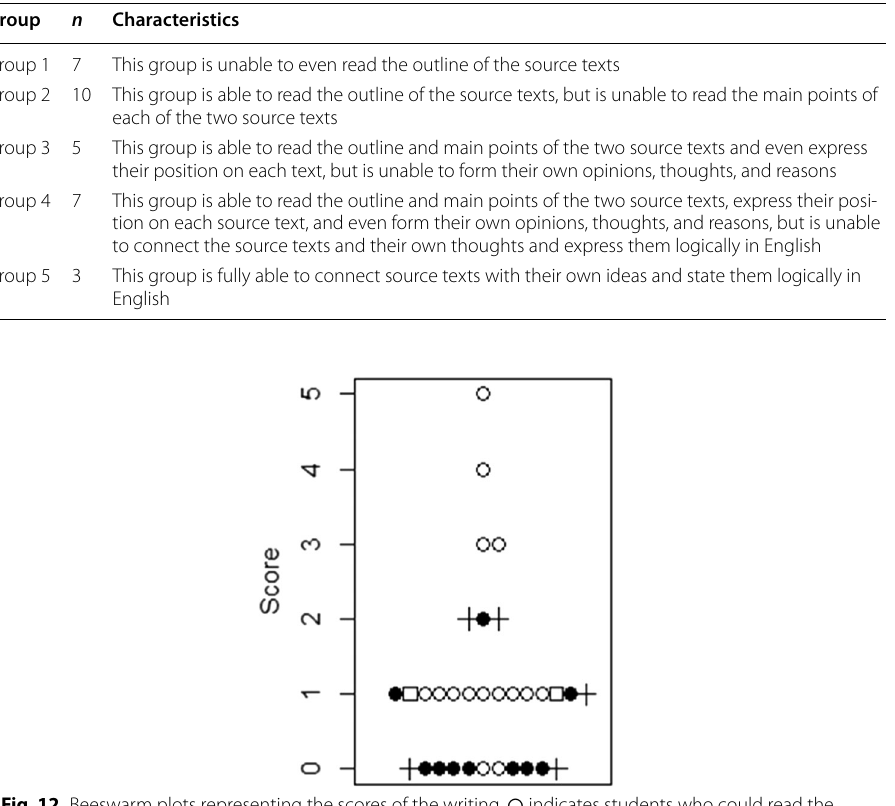
indicates those who could read neither the +